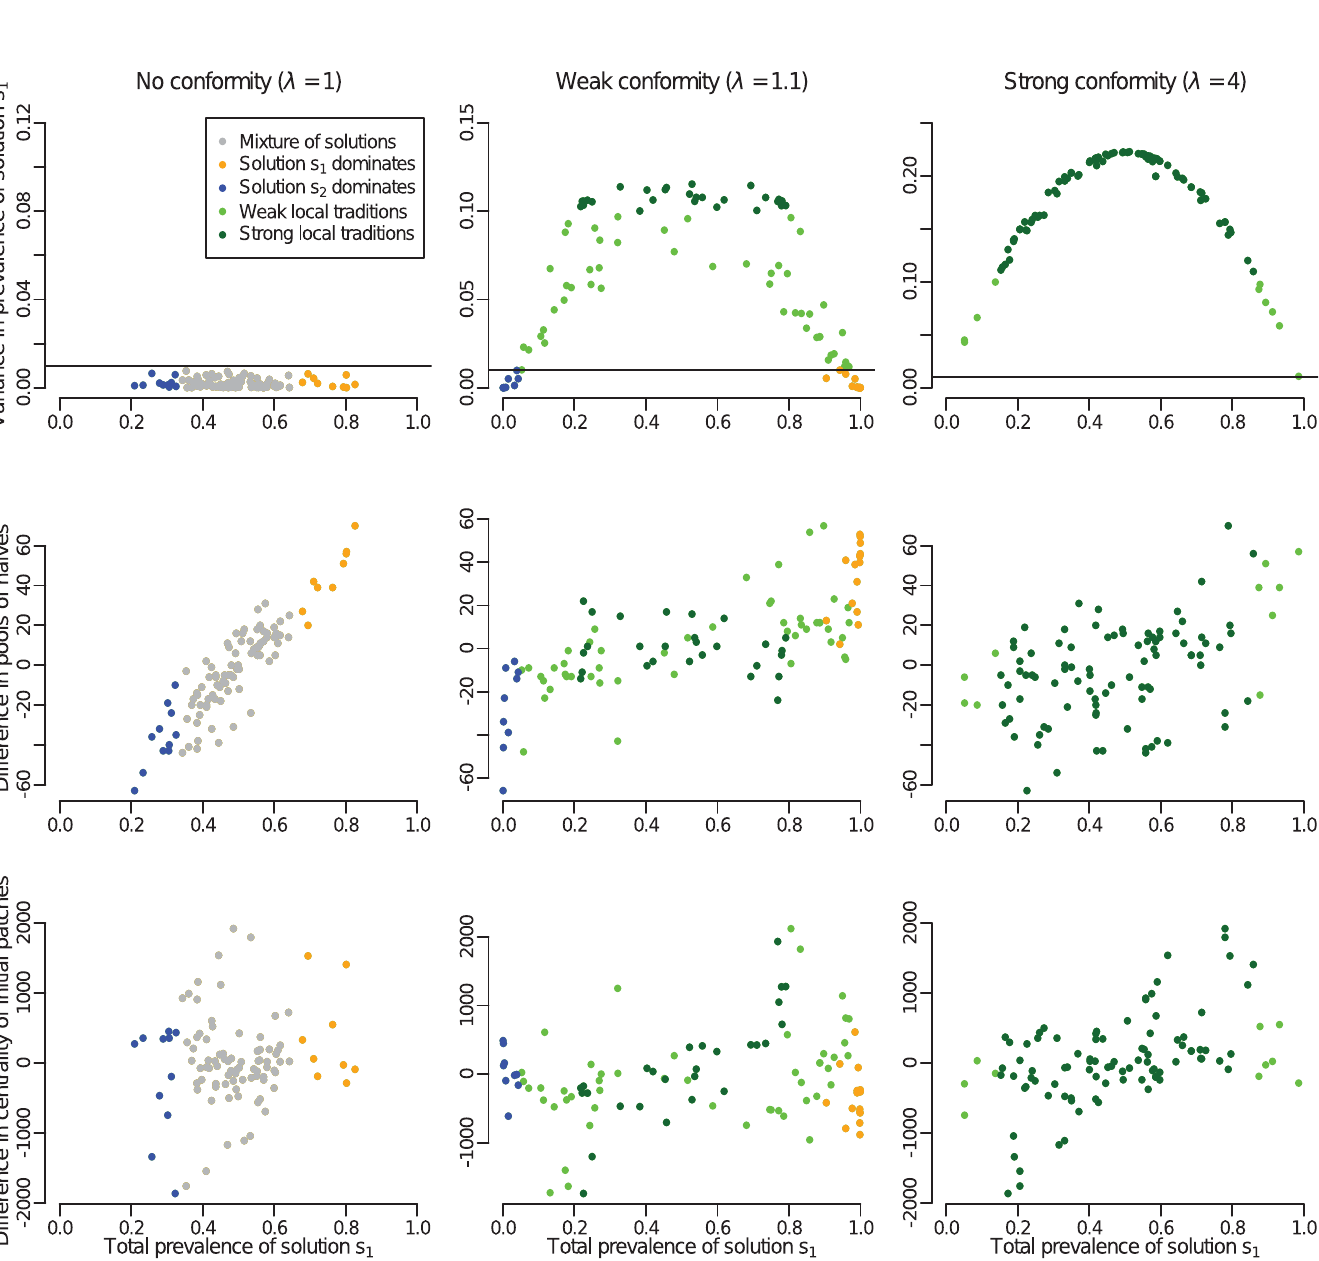
Fig 5. The outcome of the spread of information is sensitive to the initial conditions. This panel shows results for the randomisation of initial conditions for the spread of information in Wytham Woods. Each column of plots corresponds to a different conformity strength, for which 100 simulations with randomised initial conditions were run. In all the plots, each point corresponds to a model run with randomised initial conditions (i.e. where the trained innovators were introduced into the population at random locations). In each column, the same model runs are used in all three panels, and the colour indicates the type of pattern that emerges, which is indicated in the legend in the top left panel. ( Top row ) Values for the two summary statistics used to identify the emerging pattern. The colour of each point is based on where it is located in this plot. The horizontal line indicates the threshold above which local traditions were said to have emerged, and strong local traditions are said to have emerged above 0.1 for the variance of prevalence in solution s 1 . Below the horizontal line, if the total prevalence in solution s 1 was below 0.33 then it is categorised as “solution s 2 dominates” and if it was above 0.66 then it is categorised as “solution s 1 dominates”. ( Middle row ) Relationship between the total prevalence of solution s 1 (one of the two summary statistics) and the difference between the pool of na ï ve individuals initially in contact with solution s 1 and s 2 (i.e. size of the sub- population in which innovators with solution s 1 were released at the start of the simulation minus the size of the sub-population in which innovators with solution s 2 were released). ( Bottom row ) Relationship between the total prevalence of solution s 1 and the difference in the centrality of the sub-populations in which innovators with solutions s 1 and s 2 were released at the start of the simulation. The centrality of a sub-population was computed as the median distance between itself and other sub-populations (the smaller the value the more central is the sub-population). The smaller the difference in centrality, the more solution s 1 was released in a central location compared to solution s 2